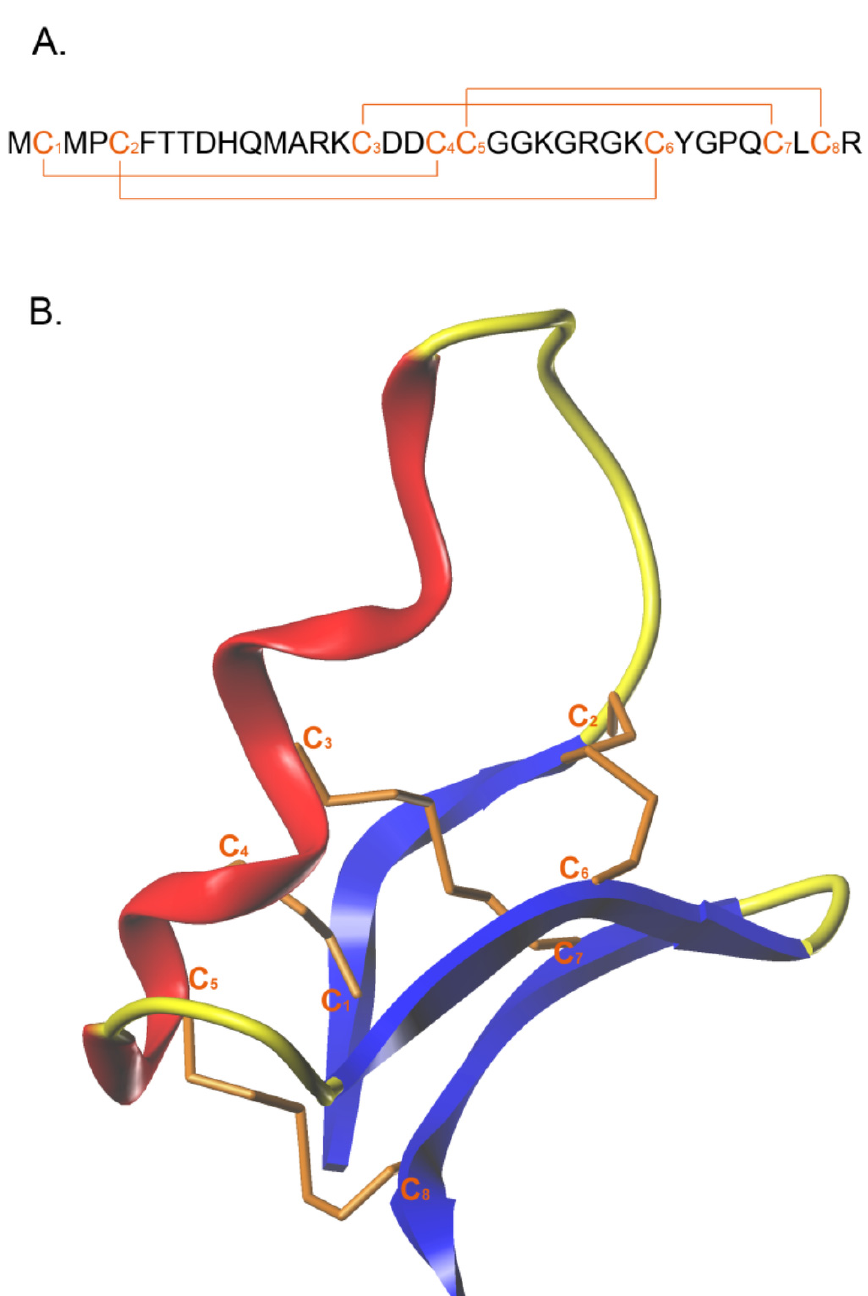
Figure 1. Chlorotoxin’s amino acid sequence ( A ) and structure ( B ) with the disulfide bonds presented. Reprinted with permission from Ref. [25], 2015, MDPI.